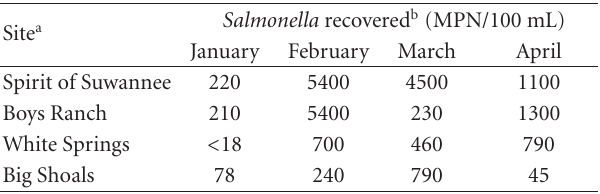
a Sites on the Suwannee River are described in Table 1. b MPN enumeration is described in the Materials and